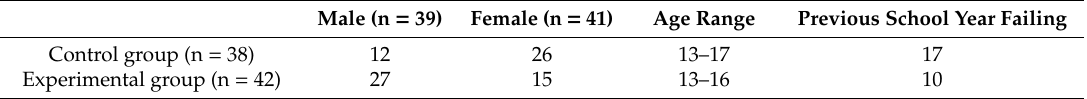
Table 1. Sample Table 1. Sample distribution.